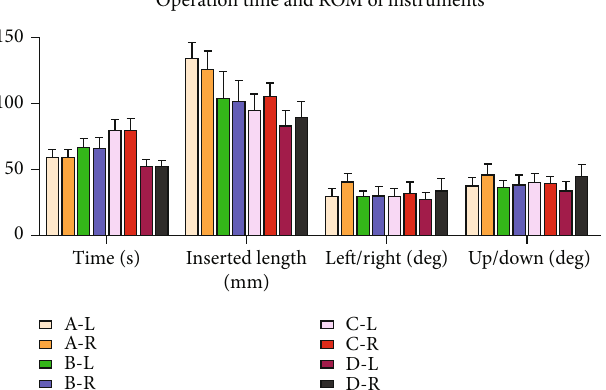
Figure 6: Operation time and ROM of instruments. Group A, straight instruments SILS; Group B, straight/articulating instruments SILS; Group C, precurved instruments SILS; Group D, straight instruments LAP. ∗ Signi fi cant di ff erence was found between groups in the operation time and interested length. p < 0 : 05 .